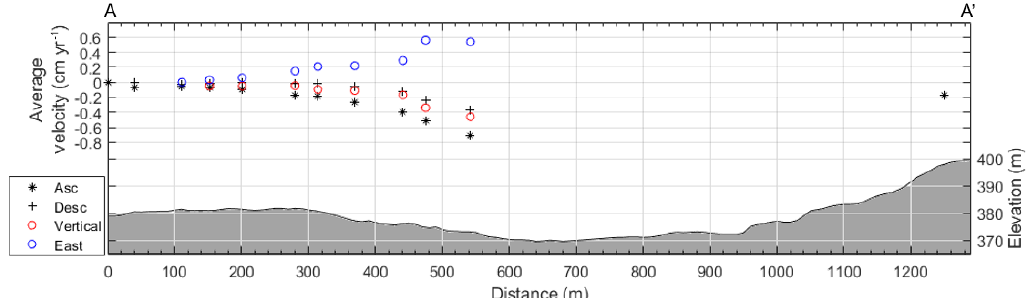
Figure 5. Cross section of topography and InSAR velocities along the A-A (cid:48) profile as shown in Fig. 3a.